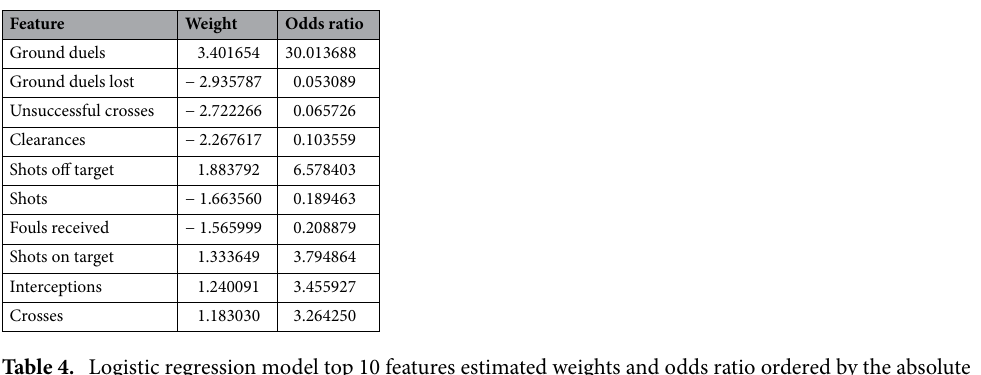
Table 4. Logistic regression model top 10 features estimated weights and odds ratio ordered by the absolute weight value. Negative weights produce odds ratio smaller than one, which indicates that predicting class male becomes less likely.